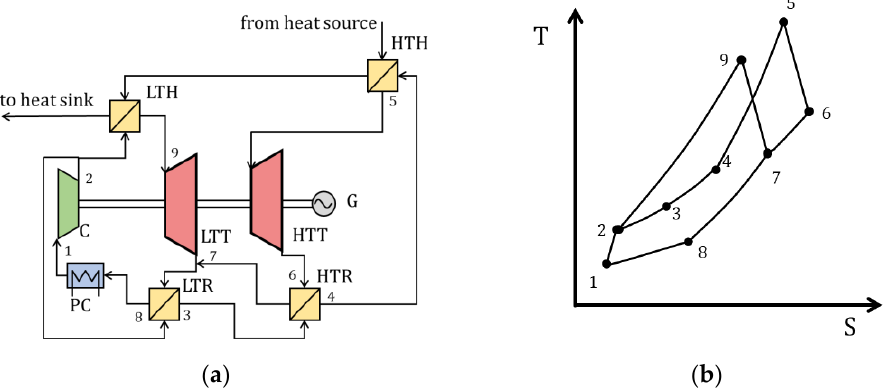
Figure 7. Cascade Brayton cycle with doubled overheating: ( a ) schematic diagram; ( b ) T–S diagram [16]. LTH—low-temperature heater; HTH—high-temperature heater; HTT—high-temperature turbine; LTT—low-temperature turbine; G—generator; HTR—high-temperature regenerative heat exchanger; LTR—low-temperature regenerative heat exchanger; PC—precooler;